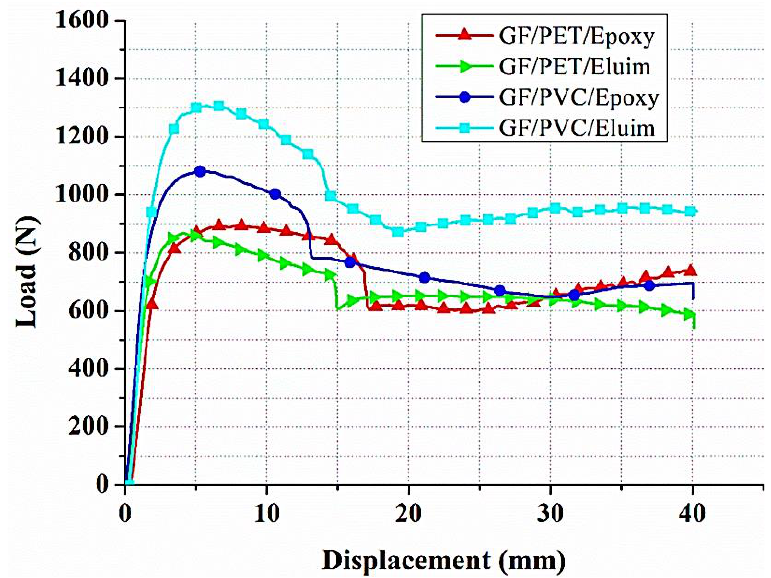
Figure 7. Load vs. displacement of sandwich glass fiber-reinforced composite structures [75]. GF/PVC/Elium = glass fiber/poly(vinyl chloride)/Elium resin; GF/PET/Elium = glass fiber/polyethylene terephthalate/Elium resin; GF/PVC/epoxy = glass fiber/poly(vinyl chloride)/epoxy resin; GF/PET/Elium = glass fiber/polyethylene terephthalate/epoxy resin. Reproduced with permission from